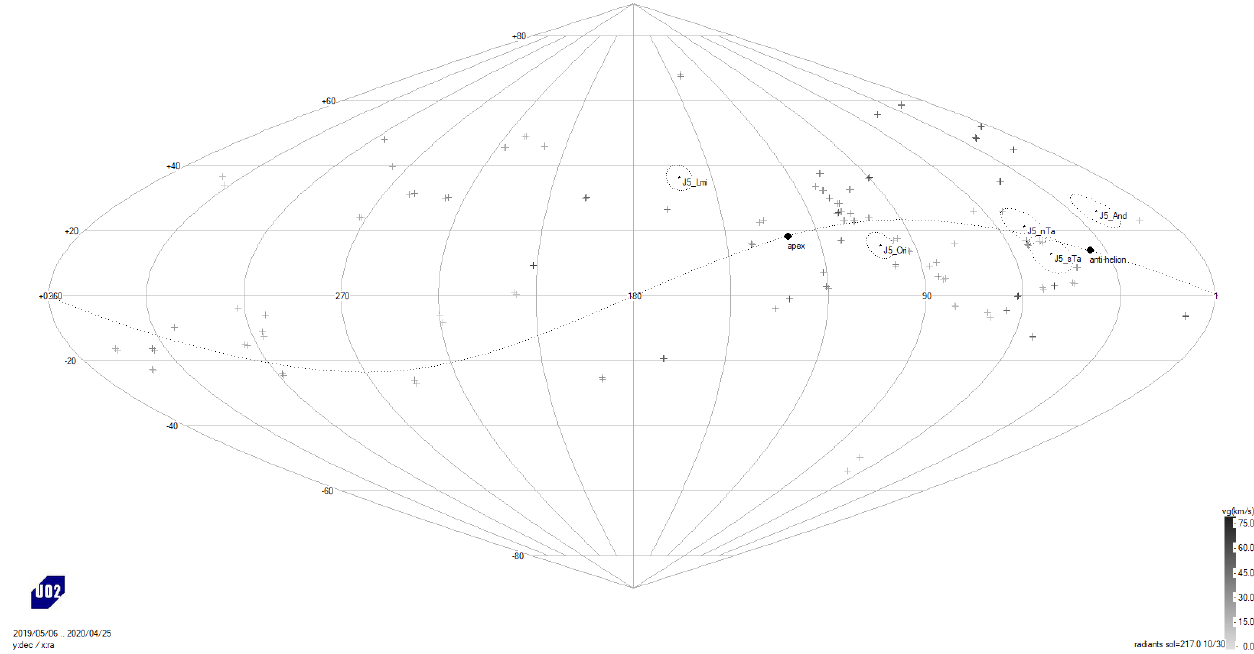
Figure 2. A radiant map of meteor observations by the Sharjah and Al-Yahar stations during the period May 2019–April 2020.